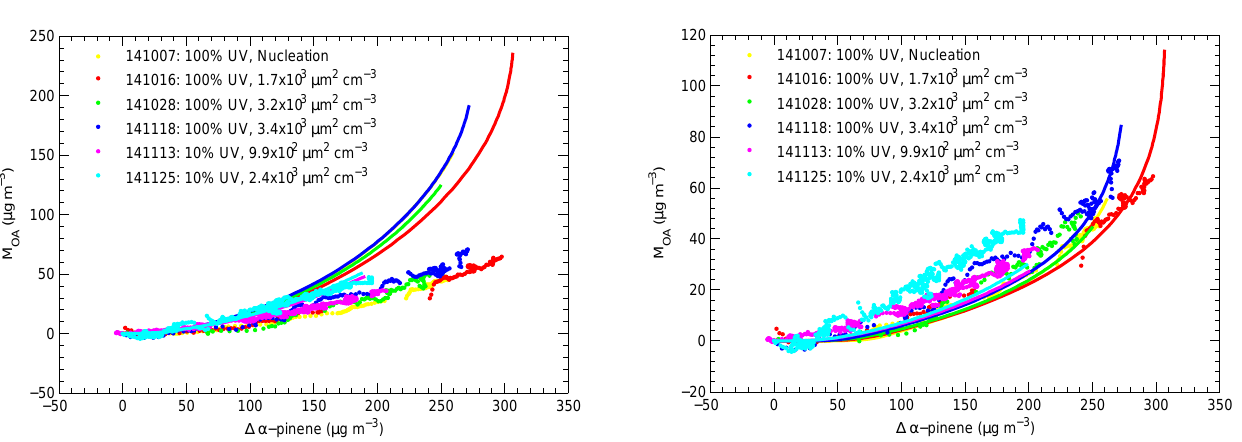
Figure 3. Mass of SOA as a function of reacted α -pinene. Ex- perimental data are shown as filled circles. Solid lines corre- spond to GECKO-A predictions using a vapor wall loss rate k gw = 10 − 5 s − 1 .